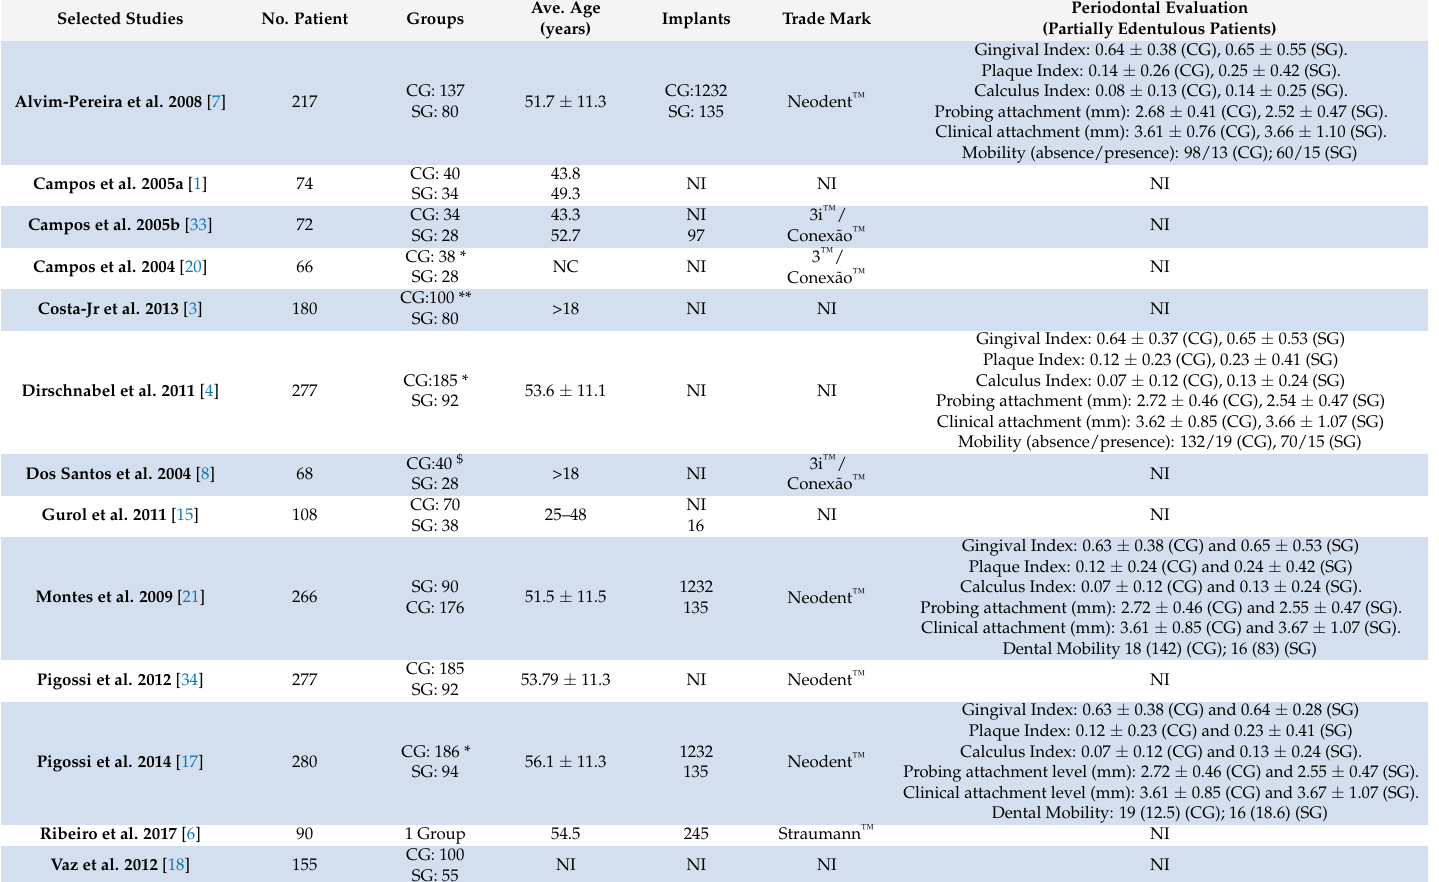
Table 2. The size of the cohorts and the dental implants clinical data of the articles selected in this study. Ave. Age Selected Studies No. Patient Groups Implants Trade (years)